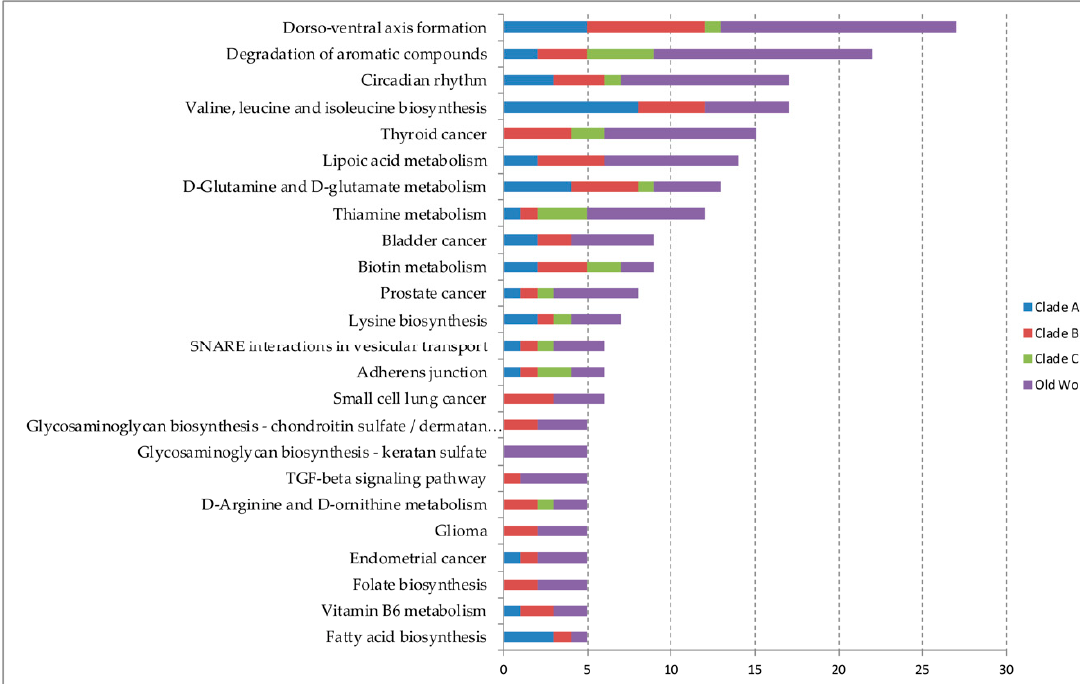
Figure 2. Top 20 main signaling pathways predicted to be regulated by microRNAs biding to mammarenavirus genome that had at least one target validated experimentally in proportion for each of the four clades (Clade A, B, C, and Old World viruses). The graphic scale is represented by the number of microRNAs that were found interacting with each pathway. The larger the scale, the greater the number of microRNAs found that are regulating the pathway.